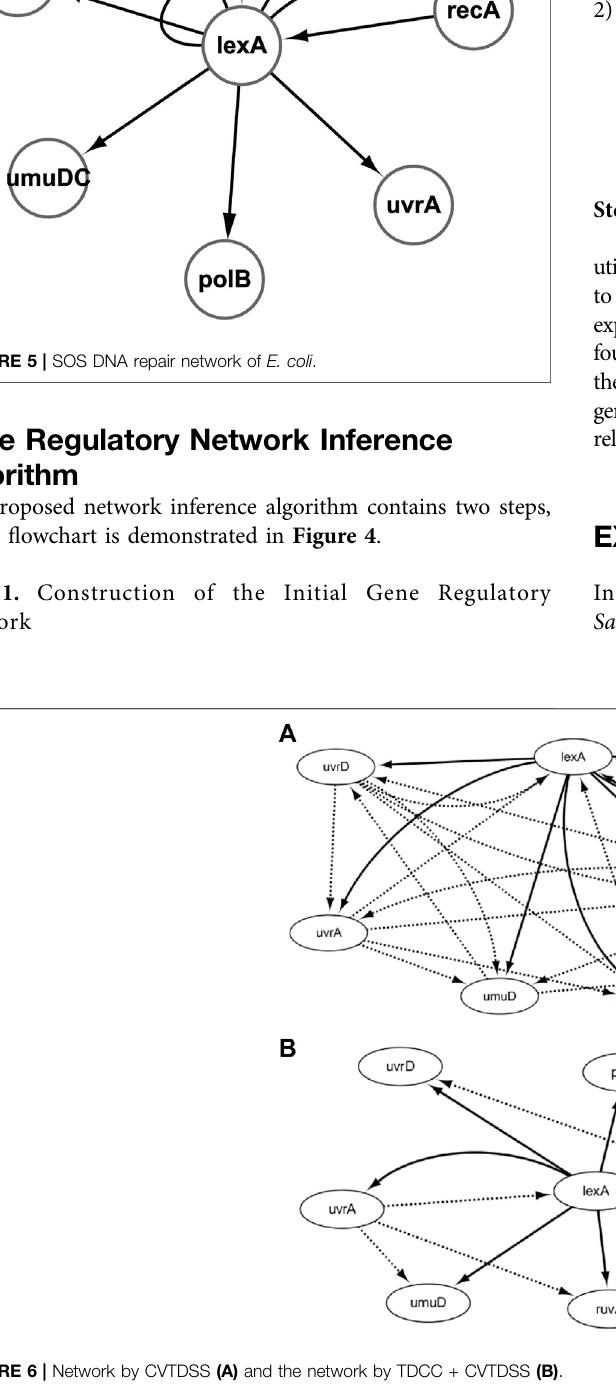
FIGURE 6 | Network by CVTDSS (A) and the network by TDCC + CVTDSS (B)